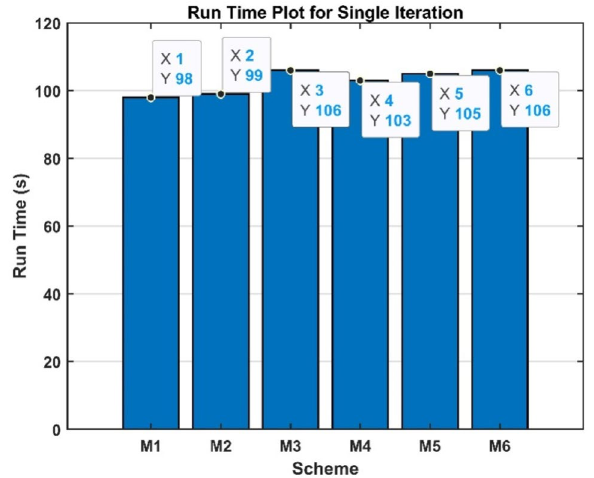
Fig. 10 Comparison plot of run times for a single iteration for all the shots in different schemes (M1-M6)